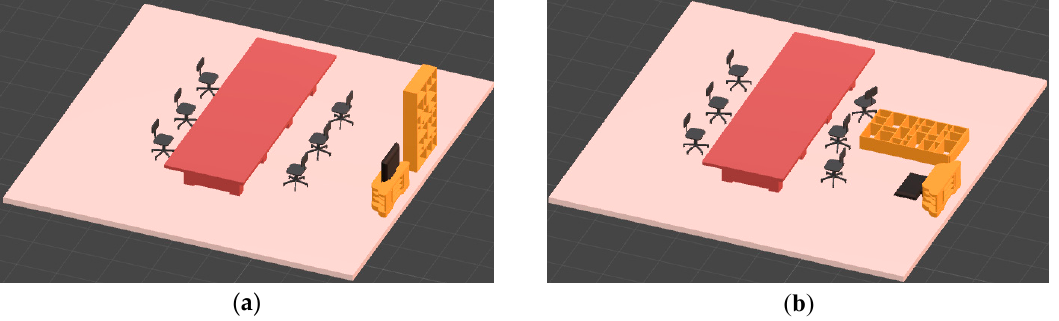
Figure 11. Movement simulation of the movable furniture, ( a ) original status; ( b ) final status